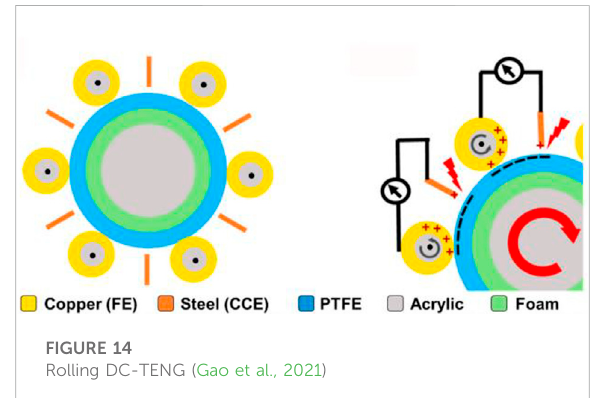
FIGURE 14 Rolling DC-TENG (Gao et al.,